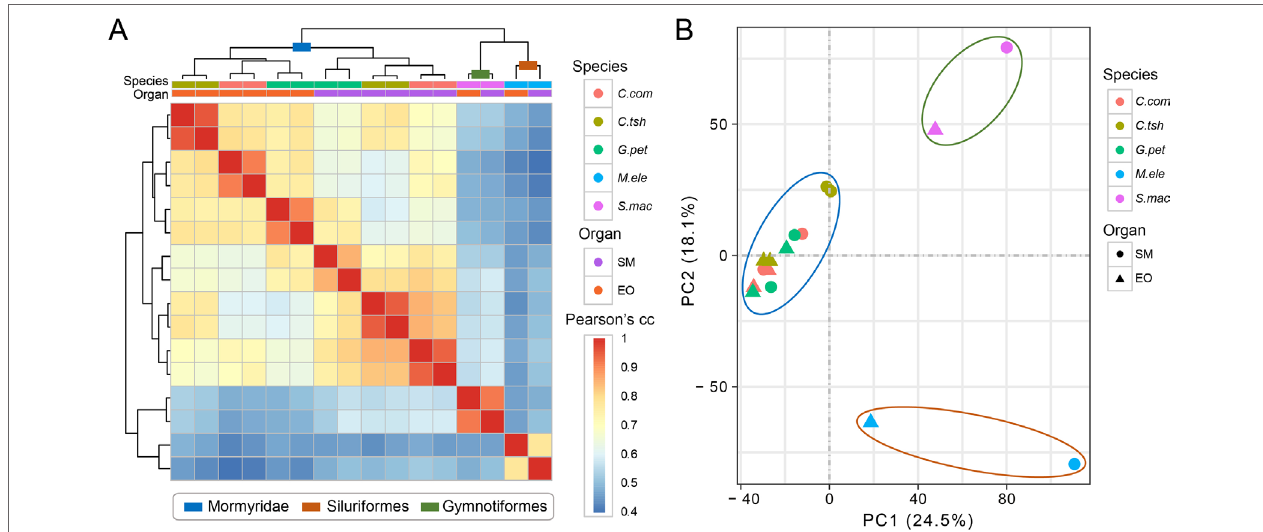
FIGURE 2 | Hierarchical clustering and PCA analysis of electric fish tissues. (A) Clustering and heat map analysis were performed using R software to cluster samples into hierarchies using pairwise Spearman’s correlation coefficient applied on Euclidean distances. The correlation coefficients are represented as a heat map, indicating variation ranging from high (red) to low (blue) similarity. (B) The PCA for all the 16 tissue samples included this study was based on the expression values of transcriptome-wide expression profiles, which determine the key variables within the data set that explain the differences between the